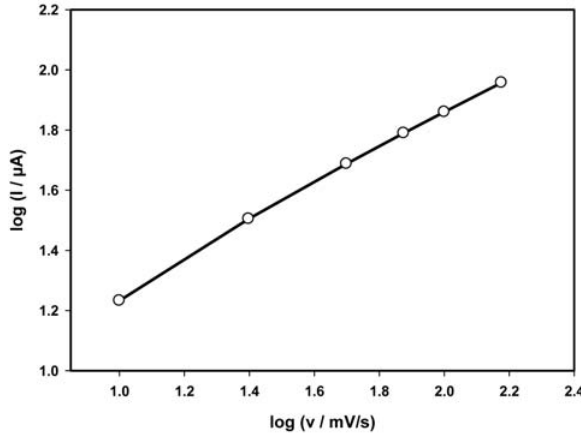
Figure 8: Anodic peak current response of 1.0 × 10 –3 mol/L MET solution at PYCPE as a function of scan rate ( ν ) in BR Buffer of p- H 2.0.